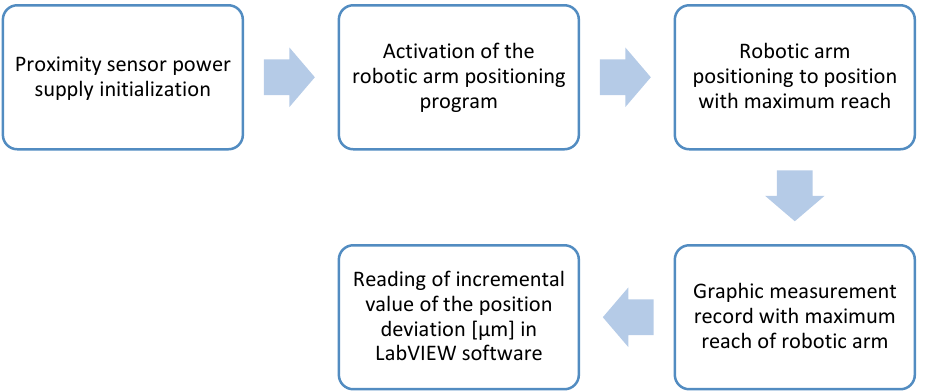
Figure 8. NcM of robotic arm’s position deviation with Arm I — AdM and Arm I — CvM. 2.5. Measurement Procedure and Evaluation of Deviations in the Position of the Robotic Arm The robotic arm was at a maximum reach of 609 mm, according to Figure 1, pro- grammed by the learning method for Arm I — AdM and Arm I — CvM. For CoM and NcM, the same program was used in the robotic arm control system. At the beginning of the measurement, the CoM of robotic arm ’ s position was selected, and n measurements were performed with Arm I — AdM in individual directions of the X; Y; Z coordinate system. NcM of robotic arm’s position deviation followed. After its completion, the disassem bly of Arm I — AdM and assembly of Arm I — CvM followed. With this arm, n measurements were performed using NcM of robotic arm ’ s position deviation in each direction of the X; Y; Z coordinate system. Then the CoM of robotic arm’s position followed. The positio n of the proximity sensor was always adjusted to each scanned position of the robotic arm in the corresponding coordinate system. The data obtained were recorded and statistically processed for n measurements, for each axis of the coordinate system, for CoM, NcM, AdM and CvM, while the individual measurements were marked with the order index i.